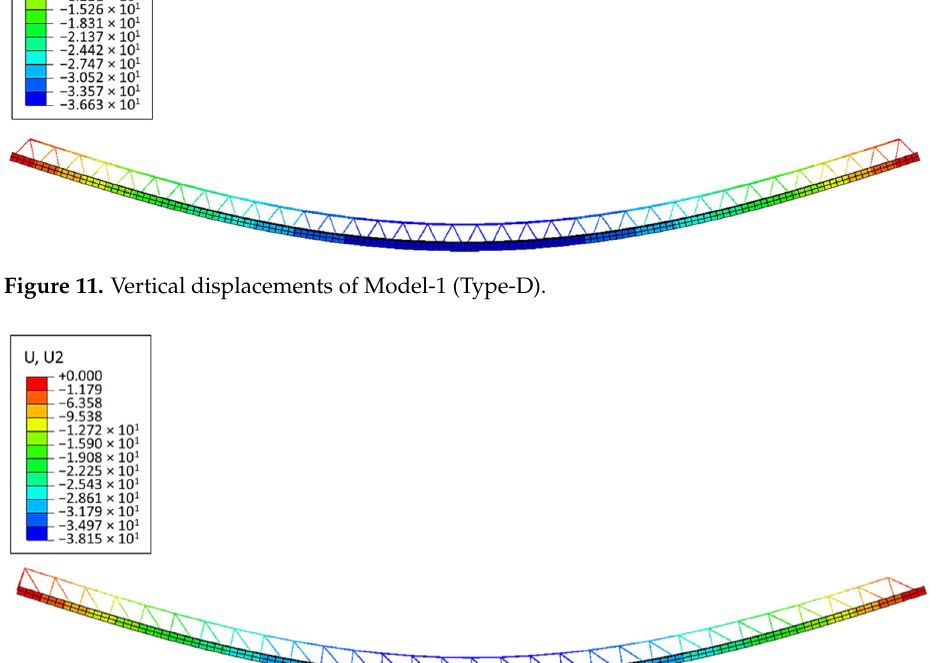
Figure 11. Vertical displacements of Model-1 (Type-D).